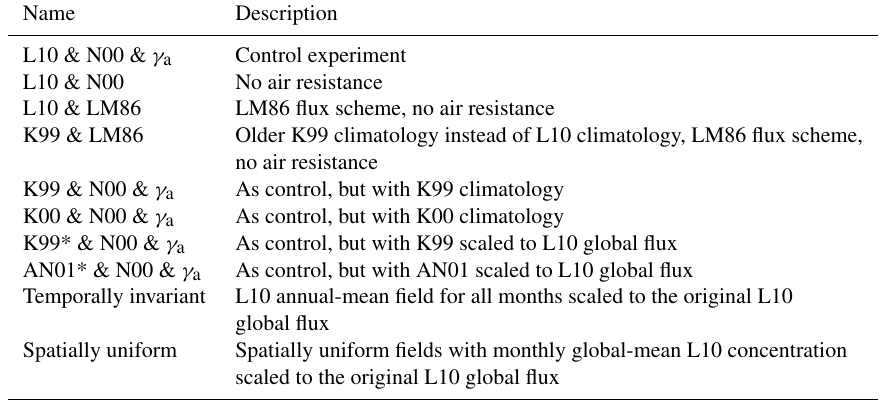
Table 1. List of model sensitivity